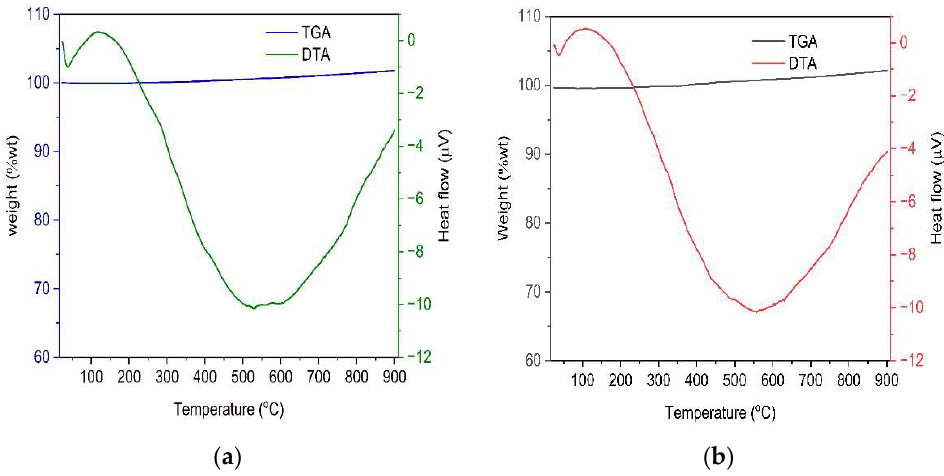
Figure 4. TGA-DTA thermograms of ( a ) VSco and ( b ) ZrOCSc before adsorption experiments.